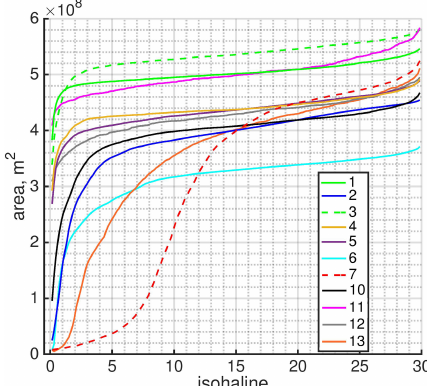
Figure 10. The mean (over the second inertial period) area of the surface projection of the isohalines for different